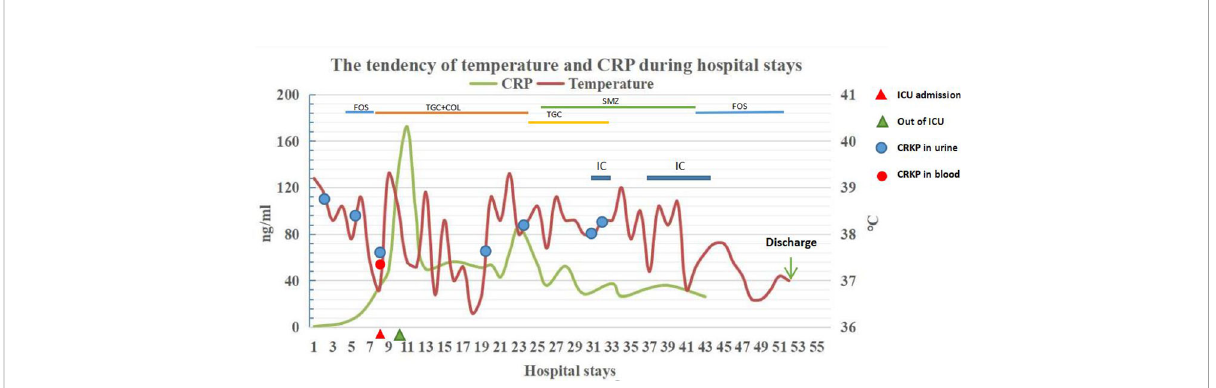
FIGURE 1 The tendency of CRP value (left Y axis) and temperature (right Y axis) during hospital stays. FOS, fosfomycin; TGC, tigecycline; COL, colistin; IC, intermittent